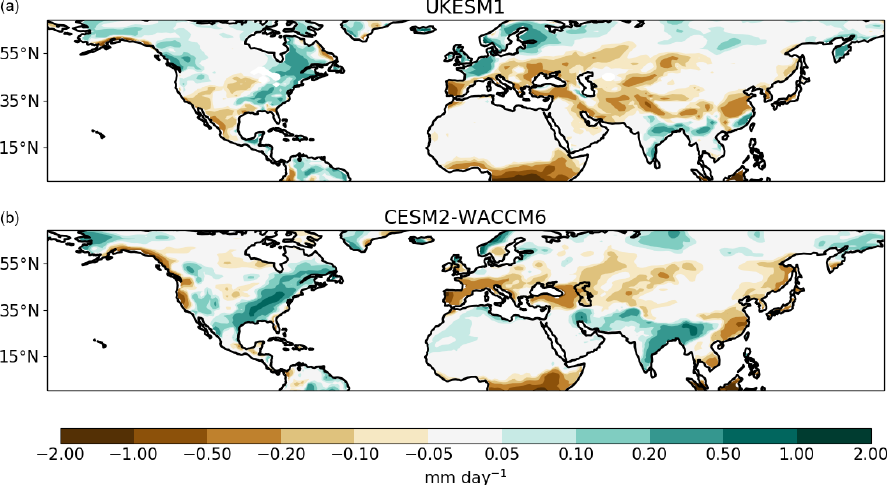
Figure 9. The perturbation to 2081–2100 mean December–February land precipitation rate (mmd − 1 ) induced by SAI diagnosed from { G6sulfur minus G6solar } for UKESM1 (a) and CESM2-WACCM6 (b) .